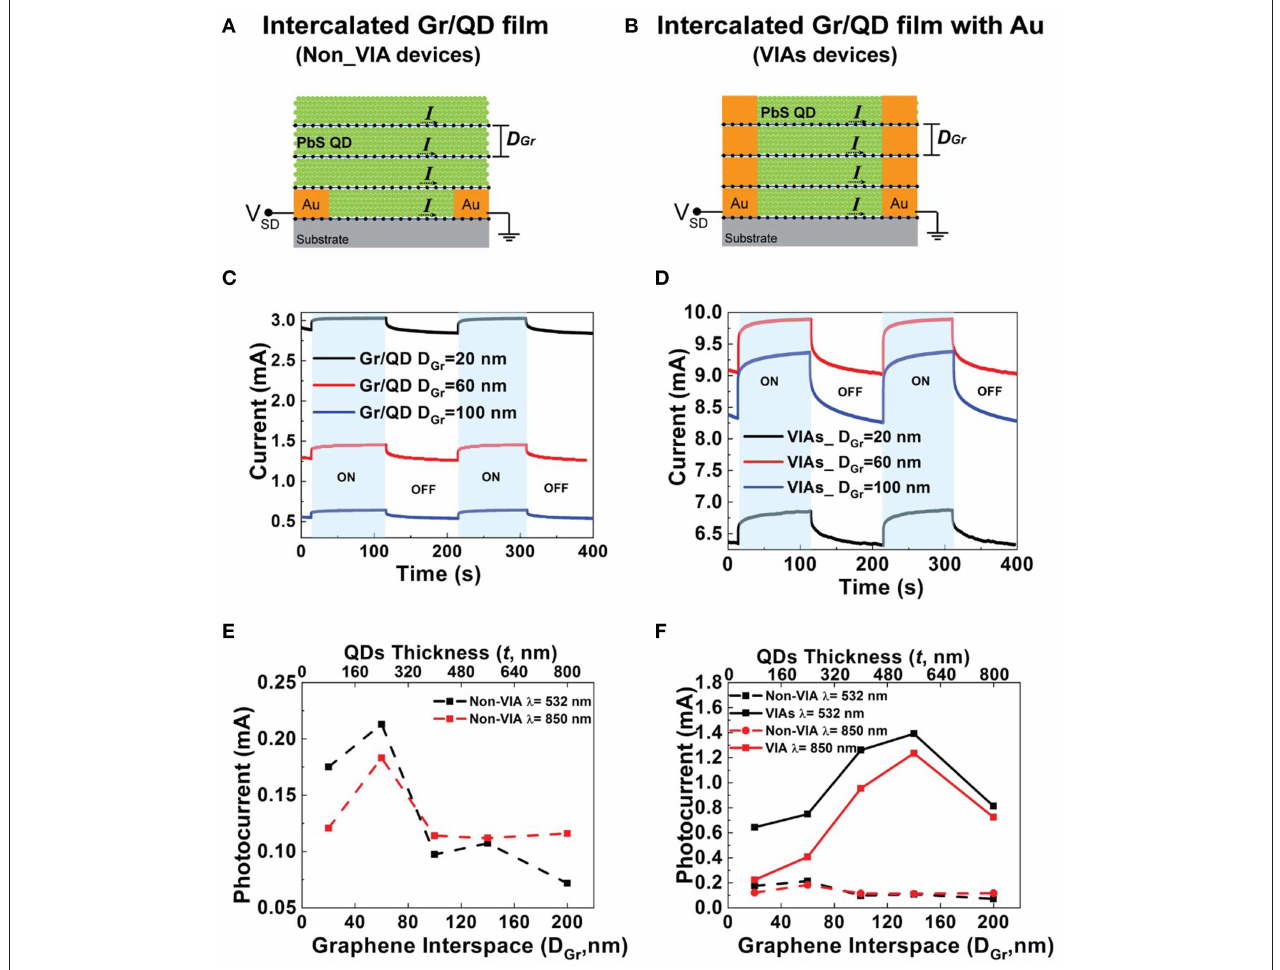
FIGURE 3 | Graphene interspace ( D Gr ) and Au VIAs. (A) Device configuration of intercalated Gr/QD devices showing the graphene interspacing parameter D Gr without VIAs. (B) Device configuration with Au VIAs, connecting each Gr layer for enhanced charge collection. (C) Light ON/OFF response for non-VIAs devices as shown in (A) with D Gr = 20, 60, 100nm stacked 4 times with total thickness of t = 80, 240, and 400nm, respectively. ( λ = 532nm, V DS = 1V). (D) Light ON/OFF response for Au VIAs devices as shown in (B) with D Gr = 20, 60, 100nm stacked 4 times ( t = 80, 240, and 400nm, respectively). The response of VIAs devices is stronger than the corresponding non-VIAs devices in (C) . (E) I ph vs. D Gr ( t = 4 × D Gr ) under λ = 532 and 850nm light for non-VIAs devices, showing highest response with D Gr = 60nm. (F) I ph vs. D Gr ( t = 4 × D Gr ) under λ = 532 and 850nm light for VIAs devices showing highest response with D Gr = 140nm. Measurements are under 532nm (0.9 mW) and 850nm (3.5 mW) laser diode